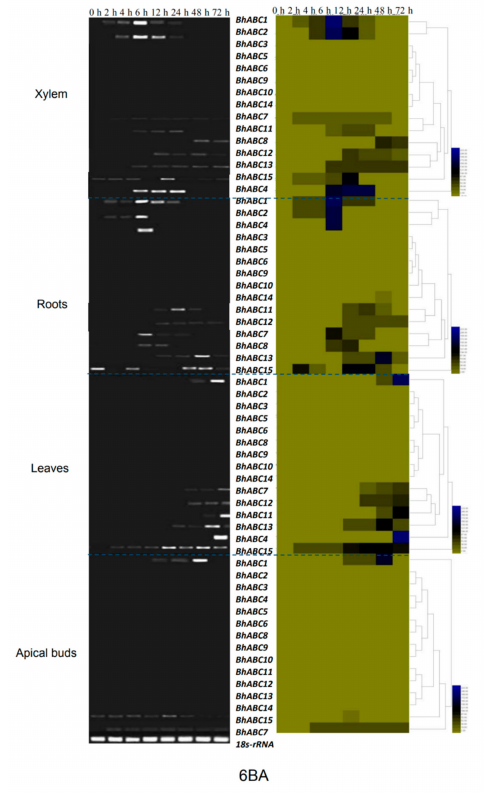
Figure 3. Expression patterns of BhABC genes in xylem, roots, leaves, and apical buds after 6-BA treatment. Heat map showing responses of BhABC genes to 6-BA (right); semi-quantitative RT-PCR analysis with 18s RNA internal reference